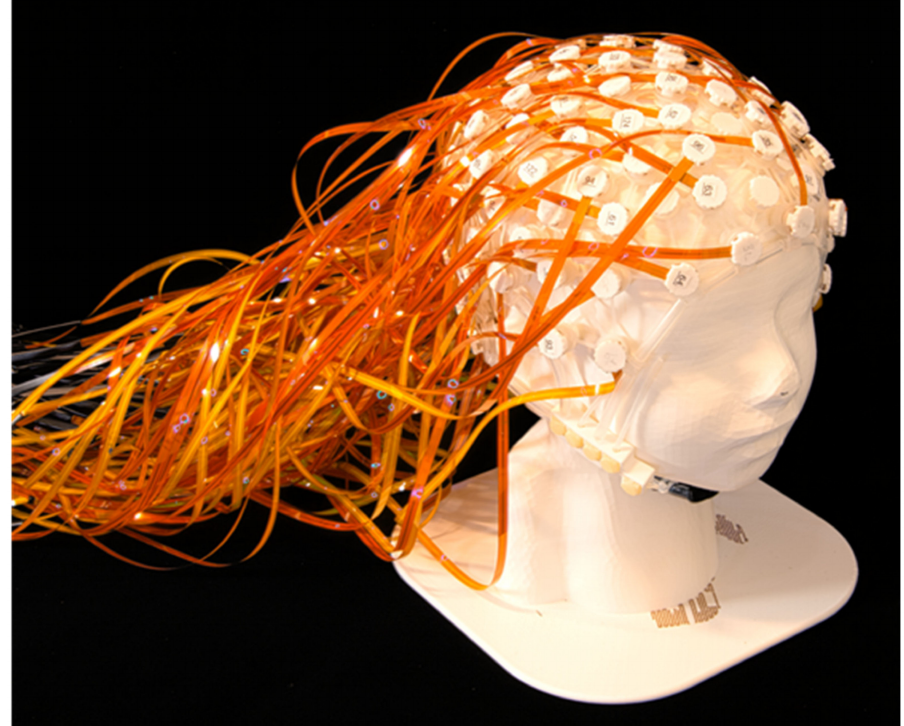
Figure 1. The NeoNet. A 128-channel high-density EEG net based on aluminum thin film